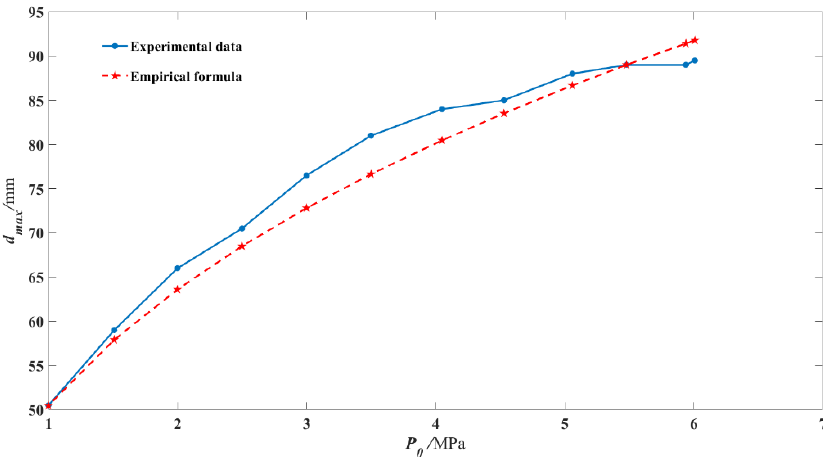
d along with max